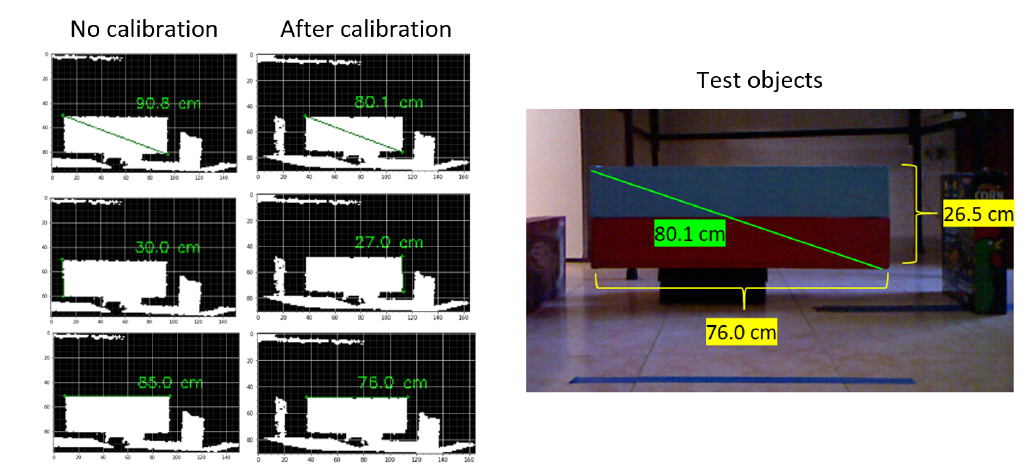
Figure 5. Calibration tests.